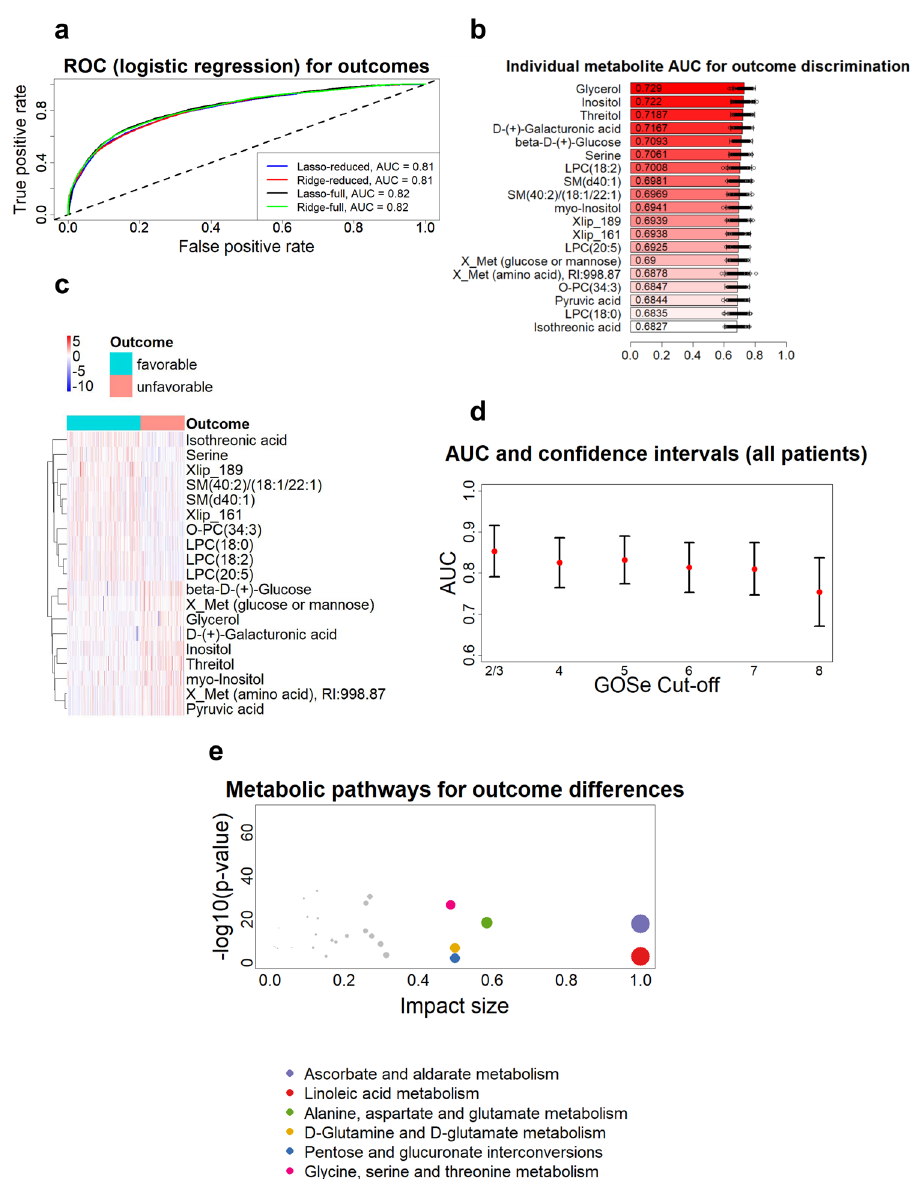
Fig. 4 Prediction of TBI patient outcomes. a The ROC curves and AUC values of four penalized logistic regression models. Lasso logistic regression and ridge logistic regression were evaluated with two sets of features each. The fi rst set of features was the full metabolomics dataset (459 features). The second set of predictors was the top features as selected by random forest feature selection and Welch t testing (19 features). The curves and AUC values are the average of 100 training/testing folds. b Individual discriminatory performance for the top 19 metabolites. Each metabolite was used in a logistic regression model as predictor, with outcome as response. The performance was averaged on 100 model runs of 70 – 30% data splits. Data are presented as mean values with the individual run performances as points ( n = 100) and aggregated 95% CI. c Heatmap of the top 19 features (also used in the reduced models in panel a ), as selected by the random forest and the Welch t test feature selection. GOSe of 1 – 4 is considered as unfavorable outcome and GOSe of 5 – 8 as favorable. Overall, patients with favorable outcomes have lower concentration of metabolite/lipid levels, with a notable exception of Glycerol, which is in higher levels in patients with favorable outcomes. d Evaluation of the discriminatory performance of logistic regression models for different cut- offs of GOSe values (1 vs. 2 – 8, 1 – 2 vs. 3 – 8, … . 1 – 7 vs. 8). The AUC (red points) and CI values are the average of 100 training/testing folds for each cut-off and each severity group. It appears that the accurate discrimination of full recovery (GOSe of 8) is not possible with the metabolomic/lipid dataset. e Pathway analysis using MetaboAnalyst 31 tool. The enriched metabolic pathways are based on differences of serum metabolites between the favorable and unfavorable outcome groups. Only signi fi cantly different pathways (FDR corrected p -values from t test) with 2 or more hits are